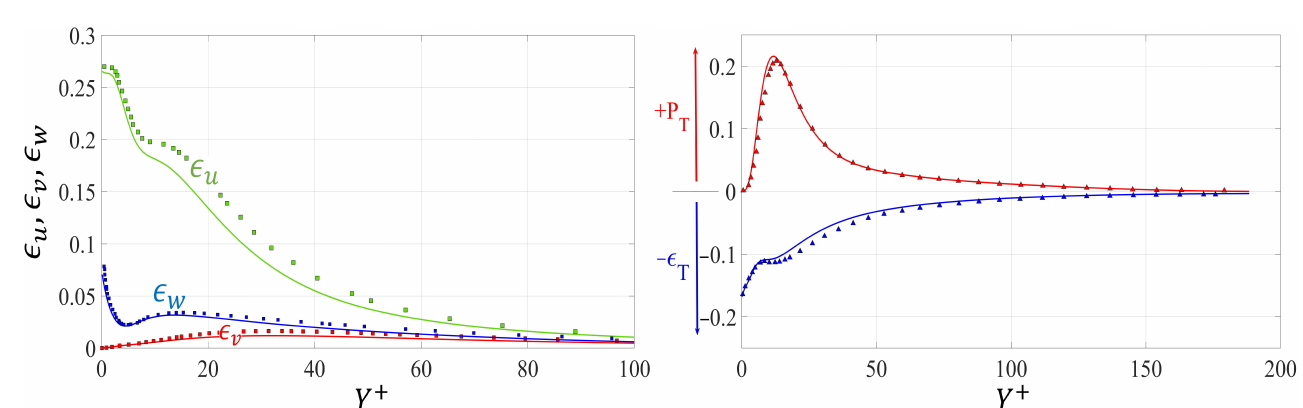
Figure 9. Components of turbulent dissipation ( left ) and production and dissipation rates of TKE ( right ). Present trends are plotted with solid lines. Reference results by Vreman and Kuerten [4] and by Mansour et al. [1] are used for validation in the left and right frames,